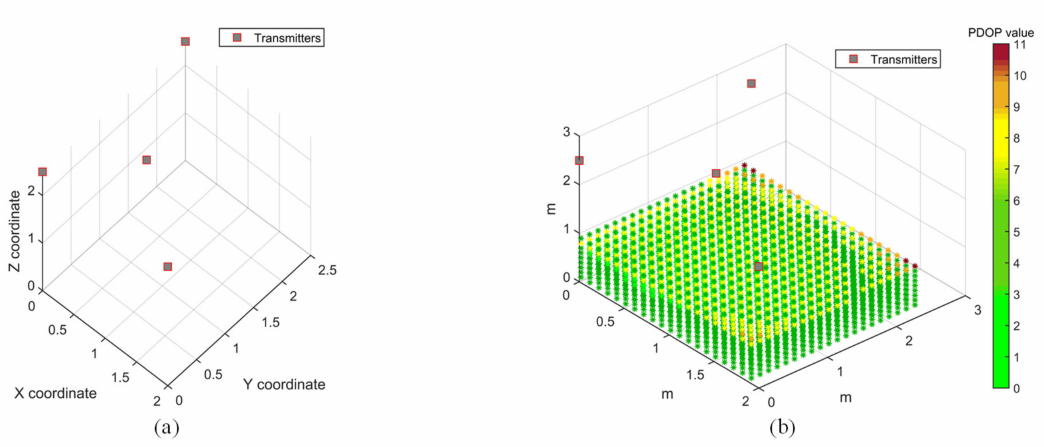
Figure 9. Transmitter arrangement optimisation using PDOP. ( a ) Optimised transmitter arrangement. ( b ) PDOP for an optimised transmitter